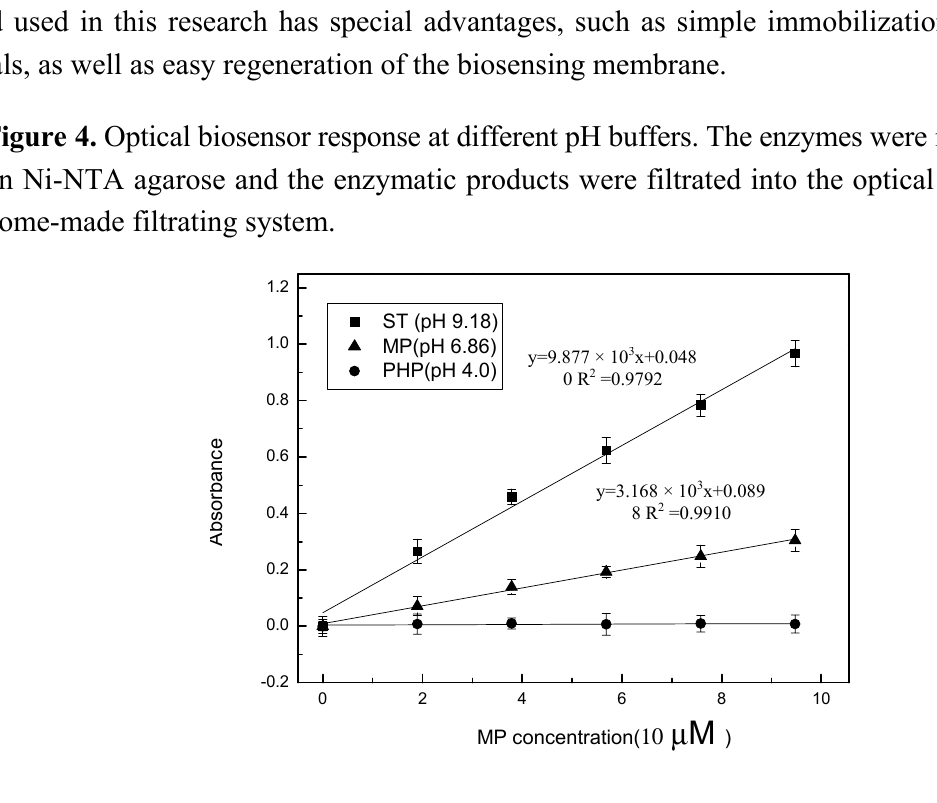
Table 1. Selection of enzyme-based biosensors for OP compound detection [12].